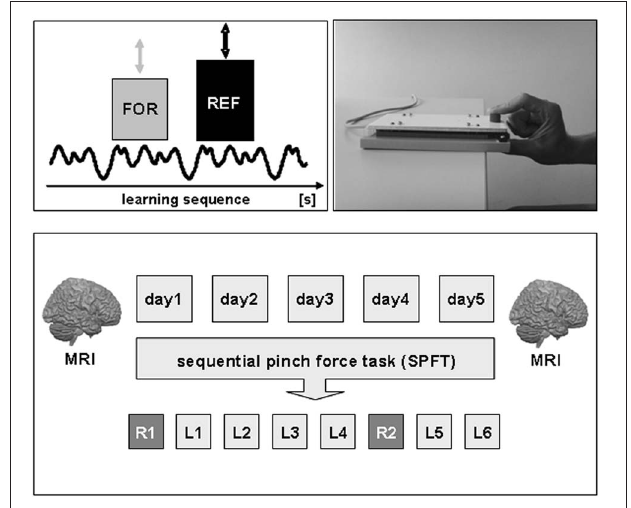
FIGURE 1 | Experimental setup and design. Subjects had to perform a sequential pinch force task (SPFT) with their right hand on 5 consecutive days (d1–d5). The SPFT consisted of a moving reference bar (REF), displayed on a computer screen, that had to be followed as exactly as possible with a force bar (FOR) that could be controlled by the individual force generation with the right hand. The SPFT was performed for a total duration of 20min each day consisting of 2 random sequences (R1–2) as well as a learning sequence that was repeated six times (L1–6). In order to assess structural brain alterations as a consequence of 5 days of motor skill learning, anatomical T1-weighted MR images were acquired at the beginning (day 1) and end of the experiment (day 5). For details see